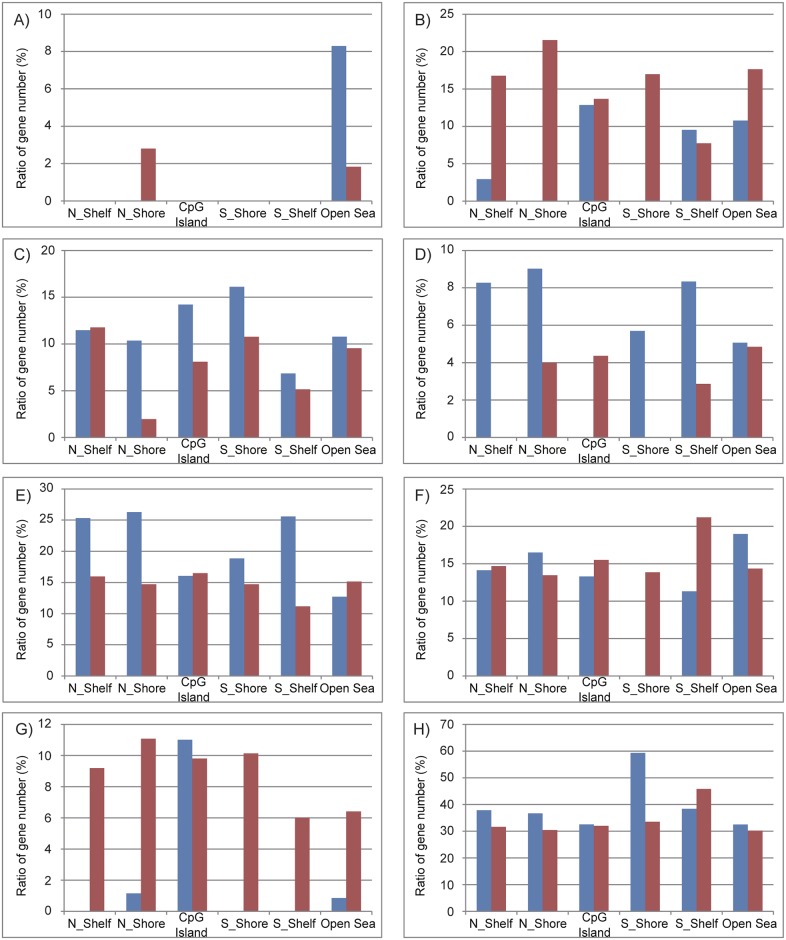
The characterization of genes hosting differentially methylated CpG sites in the CpG site subcategories.The same type of GO analyses shown in Fig 5 was applied to six CpG subcategories (N_Shelf, N_Shore, CpG island, S_Shore, S_Shelf, and the open sea). S3 Table shows the number of genes analyzed and classified.